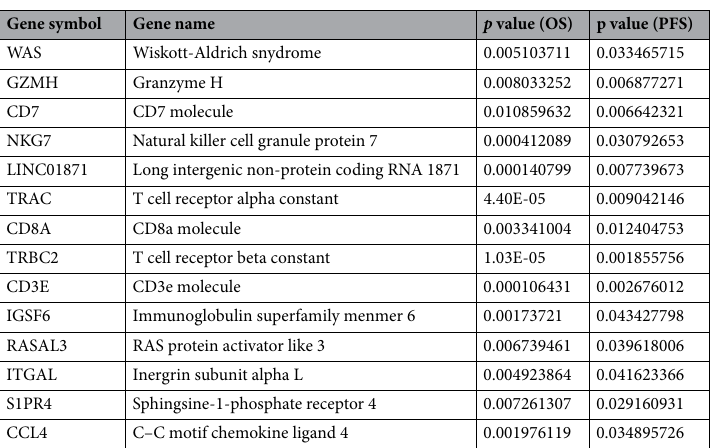
Figure 9. Mining of the immune-related genes. ( A ) The co-expressed genes that were markedly correlated with ImmuneScore/ESTIMATEScore. ( B ) KEGG enrichment analysis of the 109 genes. ( C ) Protein–protein interaction network of the 109 genes. ( D ) The degree value of each node within protein–protein interaction network.